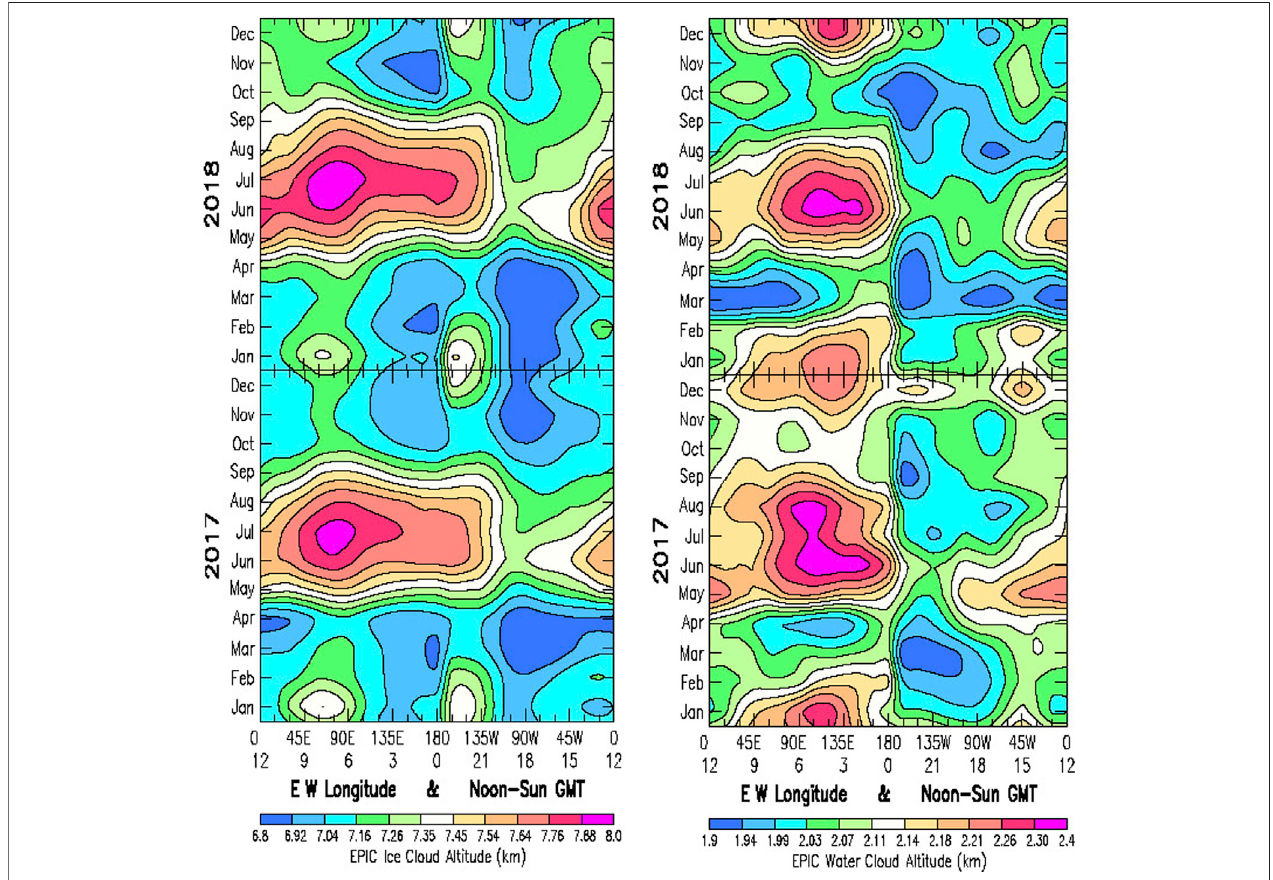
FIGURE12|Left :Hovmöllerformatice cloudaltitude fromEPICCompositeanalysisresults fortheyear 2018 (UpperLeft) and2017 (Lower Left) . Right Panel : Water cloud altitude from EPIC Composite analysis results for the year 2018 (Upper Right) , and for year 2017 (Lower Right) .